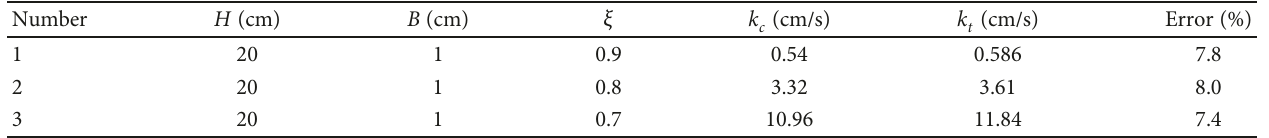
Table 5: Comparison between the experimental and computed